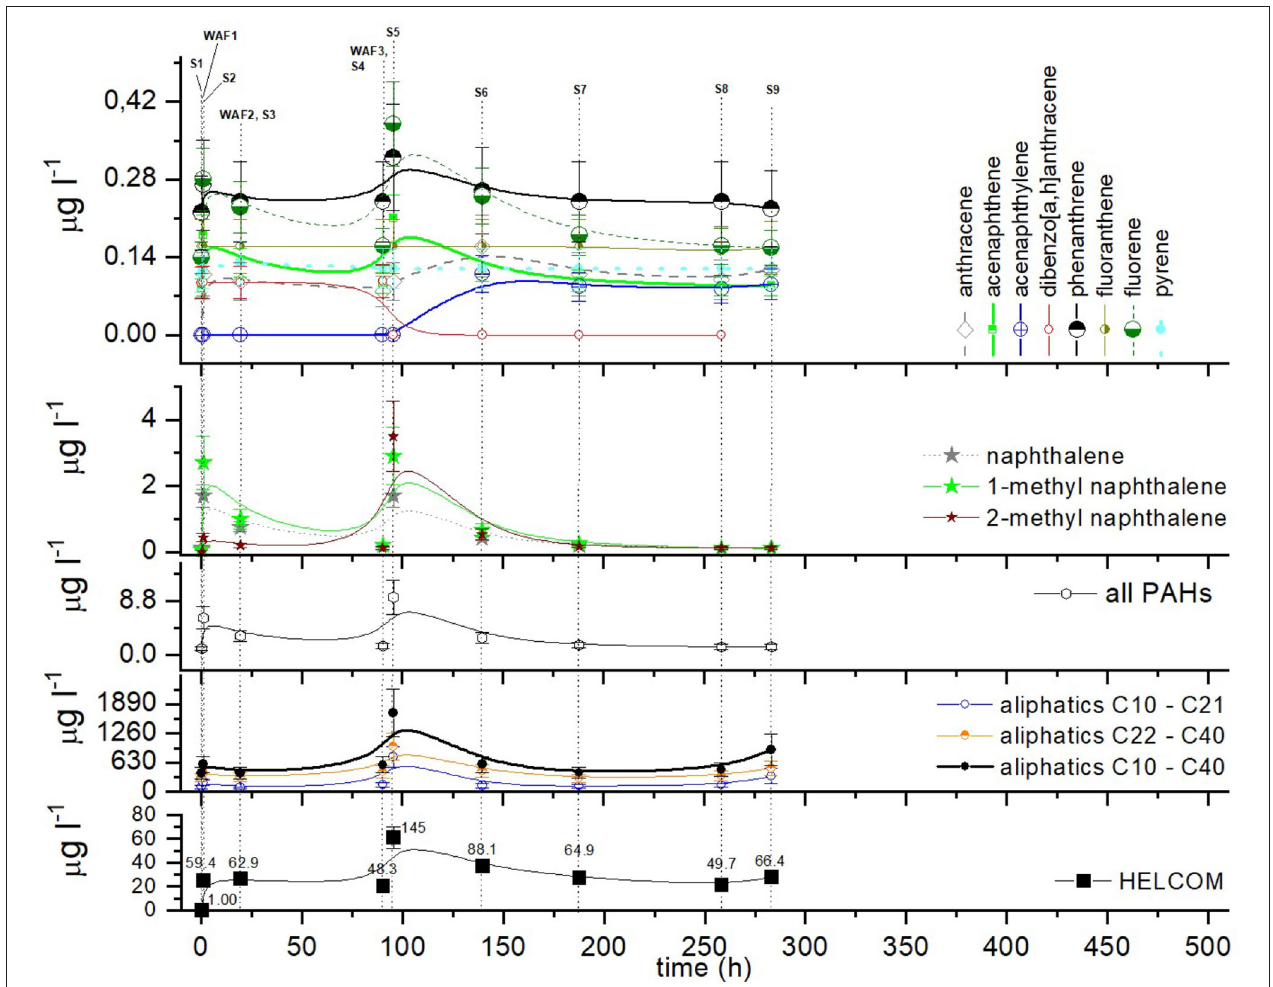
FIGURE 8 | Concentrations of hydrocarbon compounds analyzed using GC–FID (aliphatic hydrocarbons) and GC–MS (PAHs) from samples of experiment two. The values on top of HELCOM data points denote signal relative to baseline. S1–S9 are water sampling events and WAF1–WAF3 events of WAF addition.